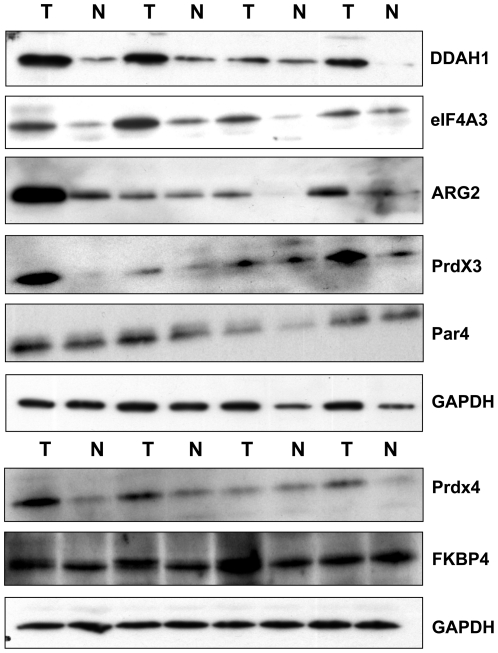
Western blot analysis of DDAH1, ARG2, eIF4A3, Prdx3, Prdx4 and PAWR in benign and PCa tissues.Protein expression identified by western blotting and only representative blots were shown here. The protein expression levels of the analysed target proteins have shown their over expression in PCa compared to normal tissue. GAPDH was used as an internal loading control.